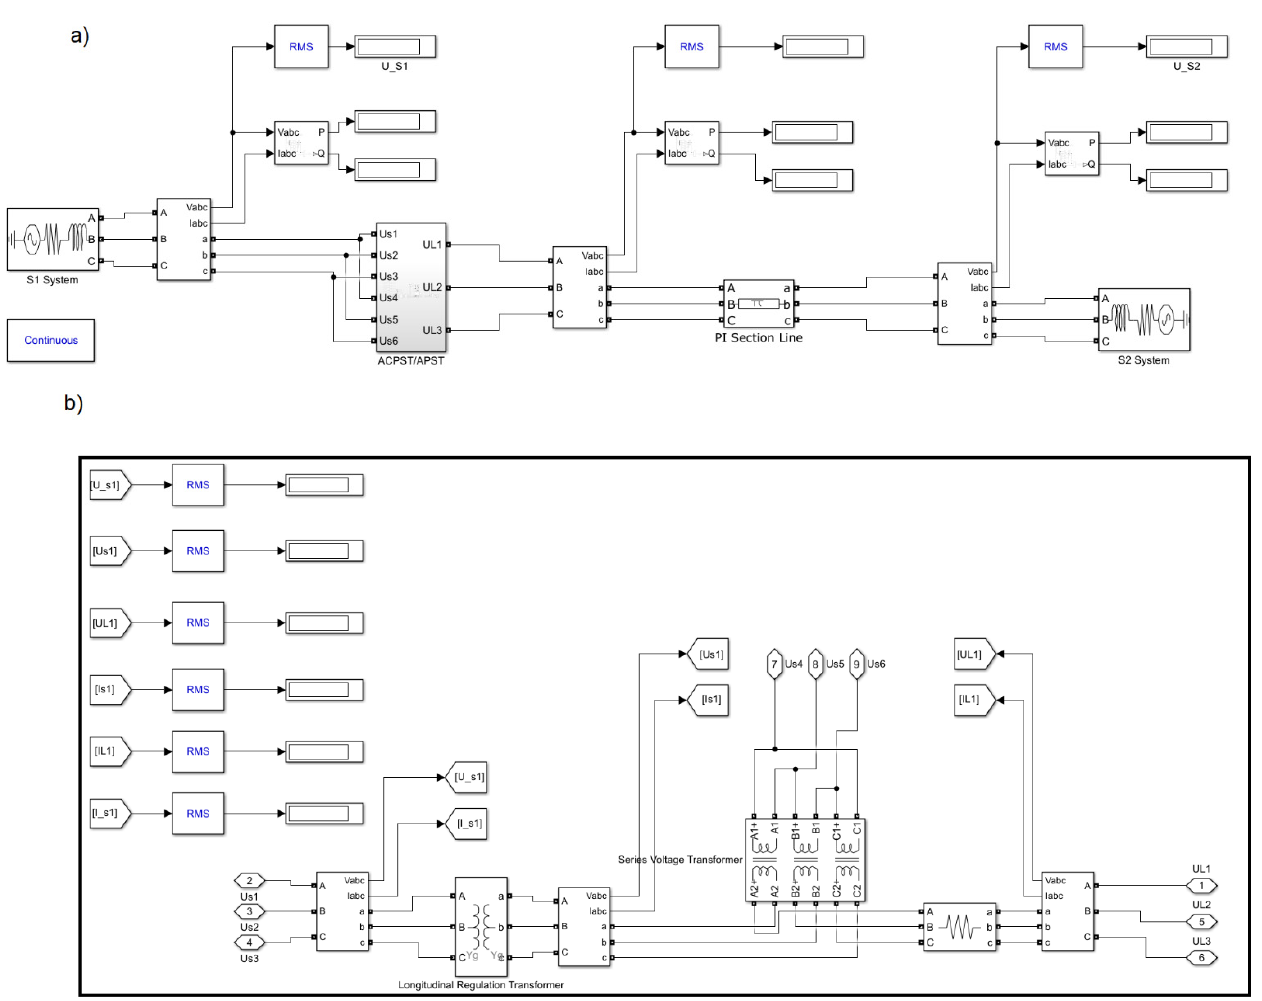
Figure 10. Simulink laboratory model equivalent, ( a ) general arrangement, ( b ) ACPST connection scheme.